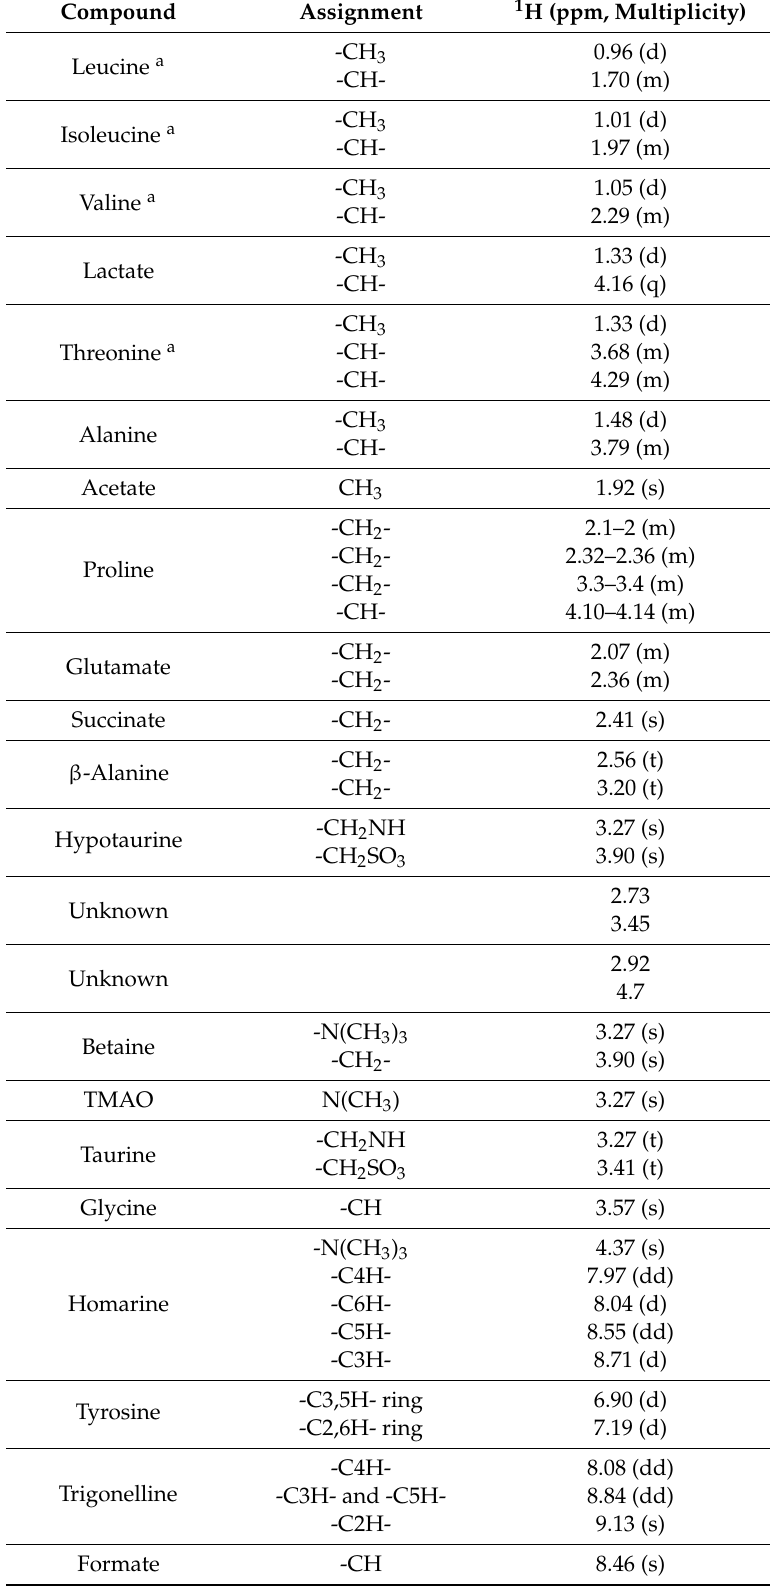
Table 2. Chemical shifts and assignments of main peaks in the 1 H NMR spectra of D 2 O extracts of the three di ff erent body compartments of R. pulmo (d: doublet; dd: double of doublets; t: triplet; m: multiplet; s: singlet). a Essential amino acid; TMAO: